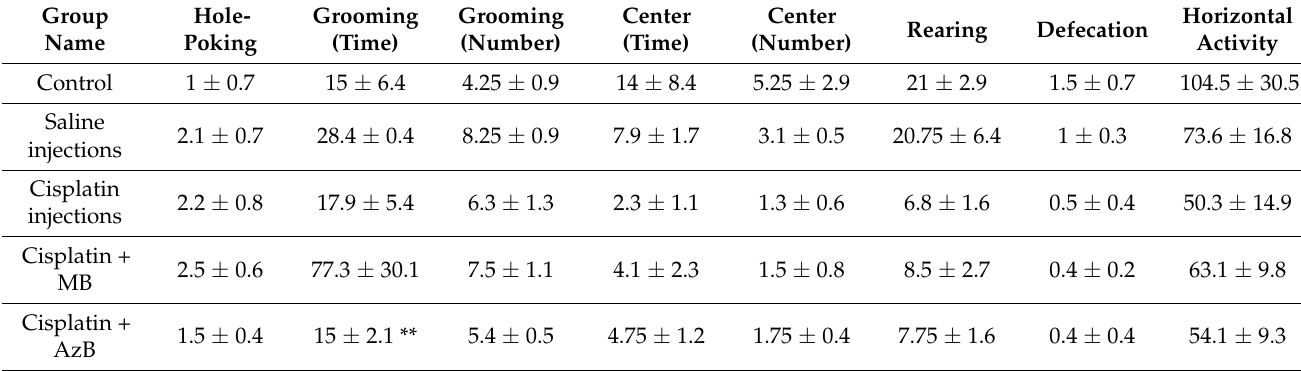
Table 1. Results of the physiological test “Open